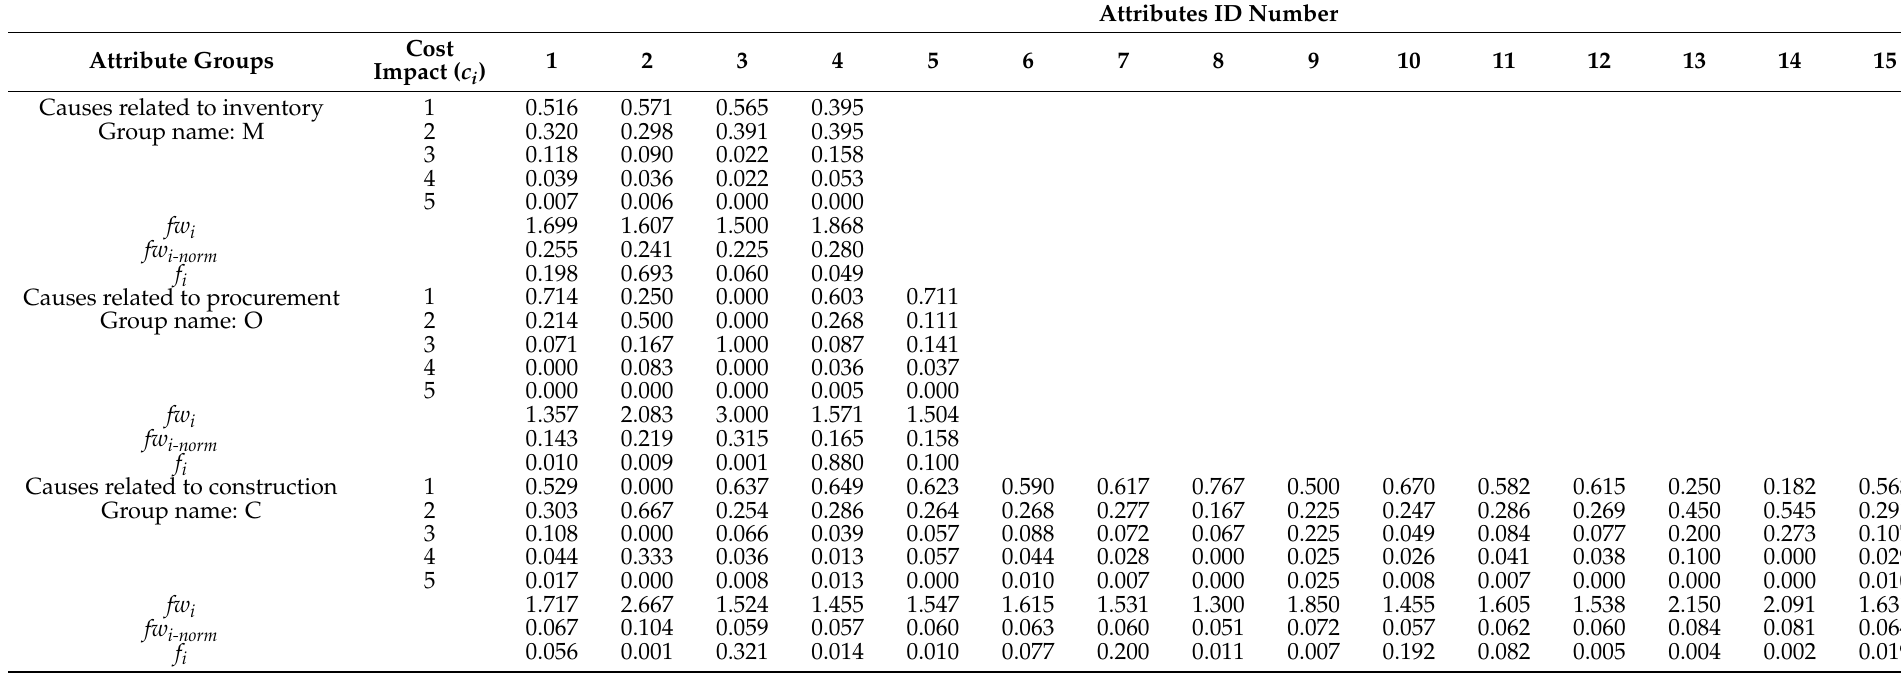
Table 7. Details of rework attributes before AHP [59].